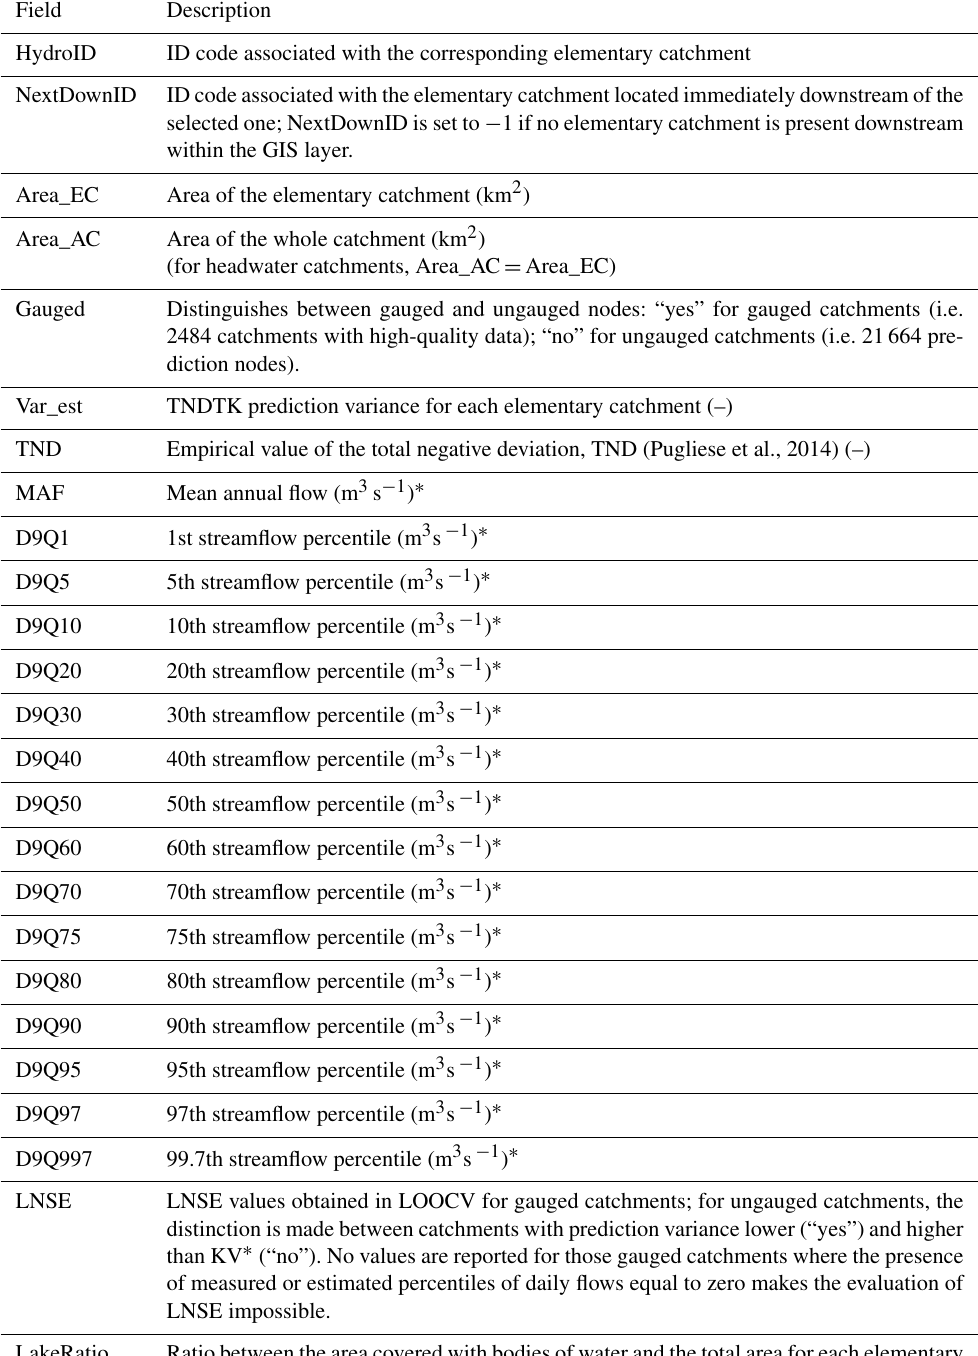
Table 1. Description of fields of the produced GIS layer reporting predicted FDCs for the entire European continent. Note that only the 2484 catchments with high-quality data are considered to be gauged and are used for predicting FDCs in ungauged